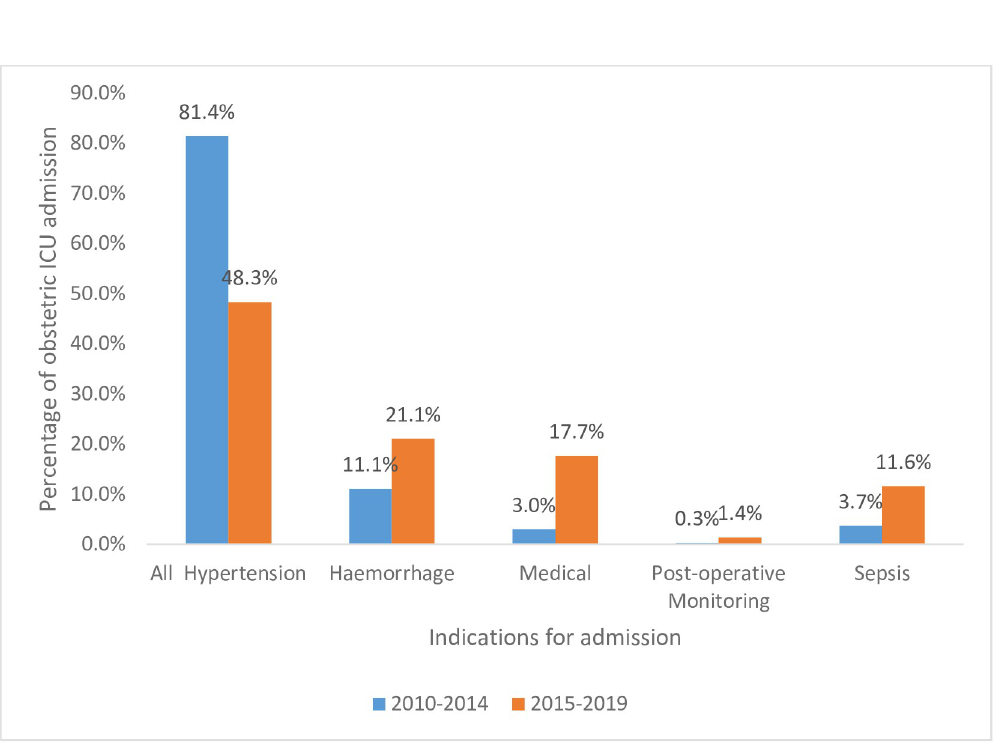
Fig 3. Comparison of major indications for obstetric ICU admission in Cape Coast Teaching Hospital between 2010– 2014 and 2015–2019.